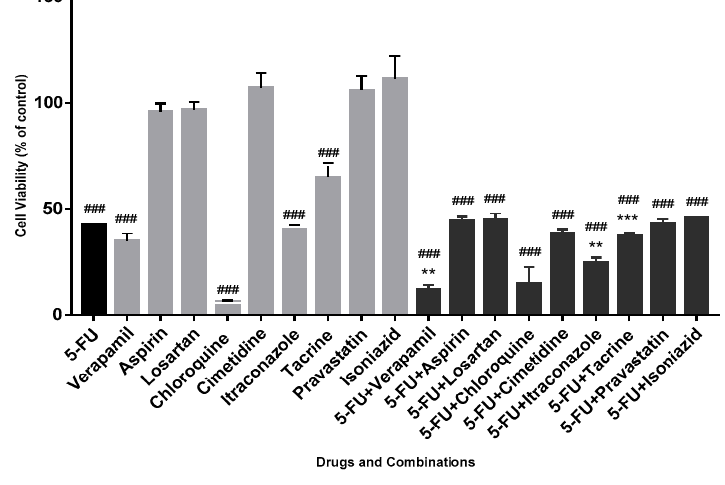
Figure 1. Effect of drugs and respective drug combinations on the viability of MCF-7 cells. Each drug and each combination were added in fresh medium, in sextaplicates. Results are presented as mean ± standard error of the mean (SEM) and represent the viability of cells (% of control) of 3–4 independent experiments ( n = 3, 4). ### p < 0.001 vs. control; ** p < 0.01 and *** p < 0.001 vs. single drug of the